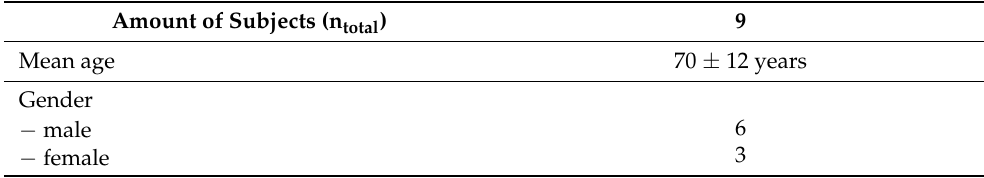
Table A1. Patient